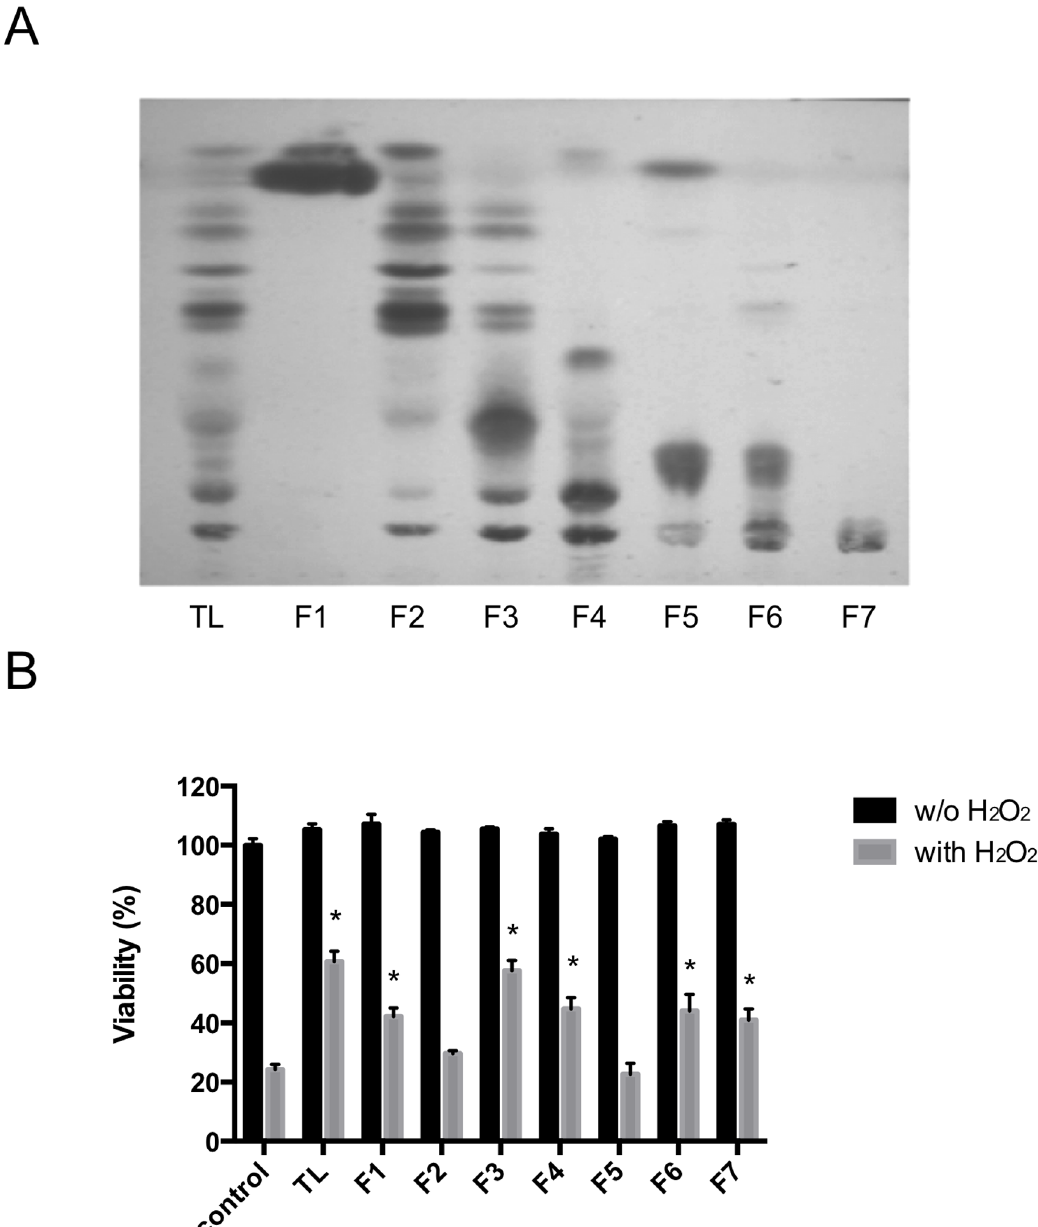
Fig 1. Thin-layer chromatogram (TLC) and cytoprotective effects of the lipids extracted from Holothuria atra . (A) TLC analysis of the lipids extracted from H . atra using a chloroform – methanol – water mixture (65:25:4, v/v/v). The total lipid (TL) was applied to a silica gel column in chloroform and eluted with: (F1) chloroform – methanol (4:1 v/v); (F2) chloroform – methanol (2:1 v/v); (F3) chloroform – methanol (1:1 v/v); (F4) chloroform – methanol (1:4 v/v); (F5) methanol; (F6) chloroform – methanol – water (3:6:1 v/v); or (F7) chloroform – water (4:1 v/v). (B) Viability of J774A.1 cells treated with the extracted